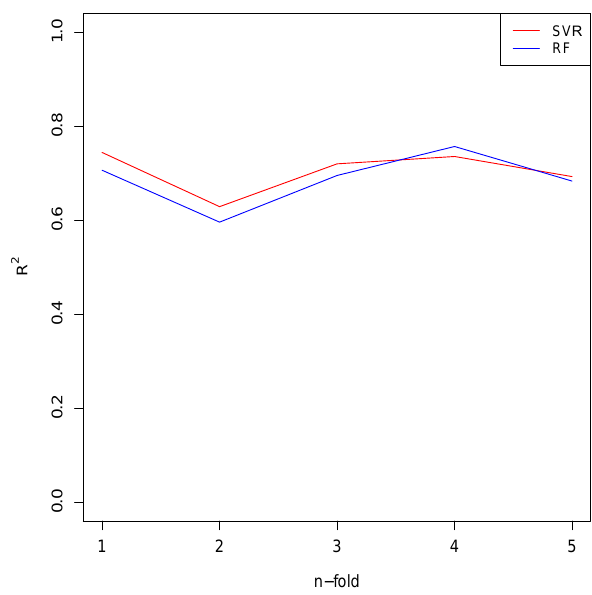
Figure 8. Coefficient of determination R 2 of RF and SVM for a 5-fold